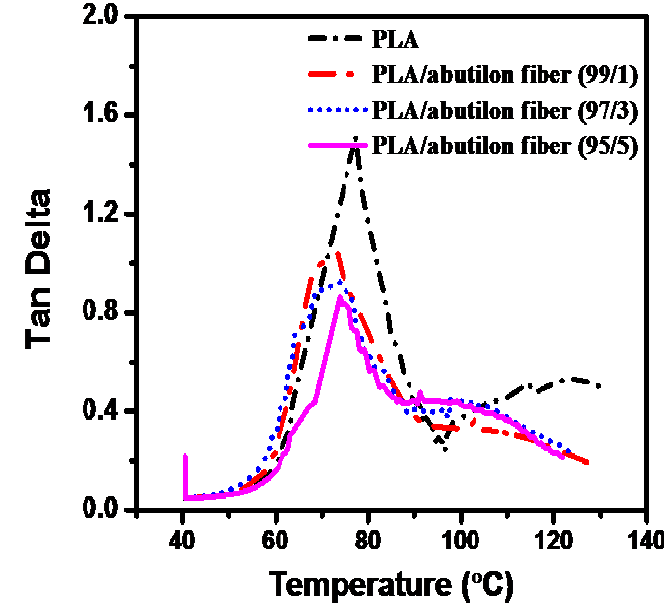
Figure 8. Tan delta of the composite samples (PLA/abutilon fiber).